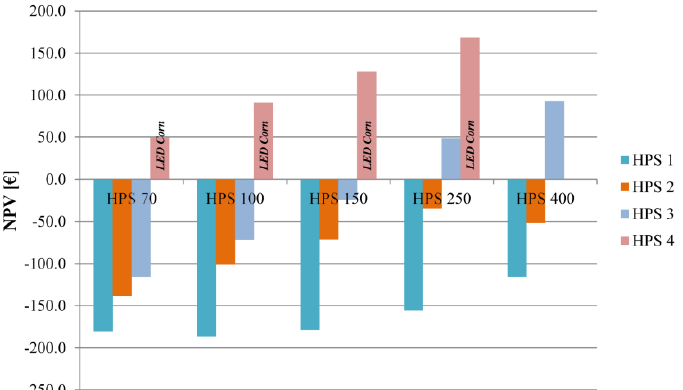
Figure 9. NPV of proposed energy efficiency measures for HPS lamps.